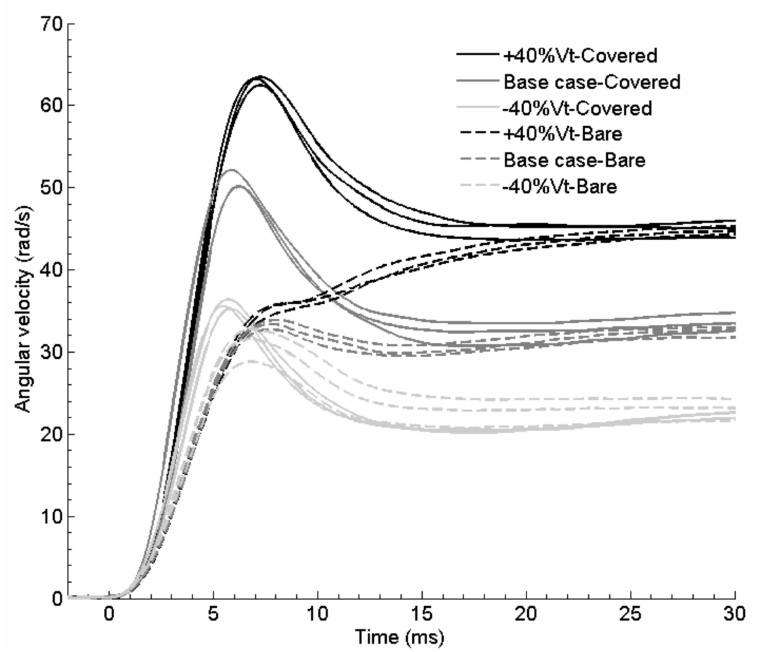
Figure 12. Resultant angular velocity for the right side impacts. Solid lines correspond to covered headform and dashed lines correspond to bare headform